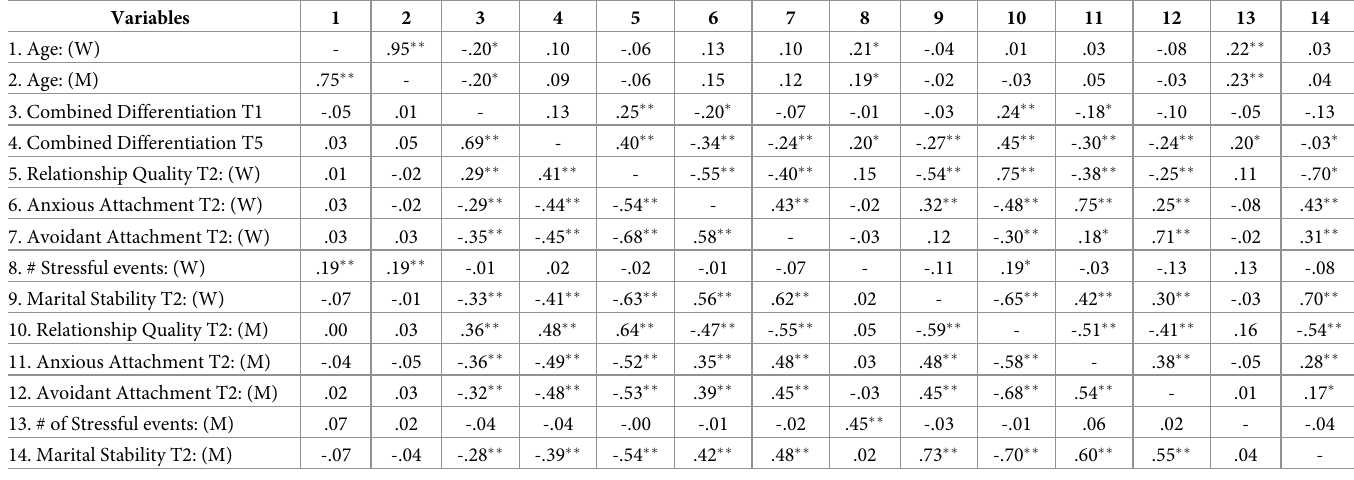
Table 2. Correlations among study variables for Spanish and U.S. couples. Variables